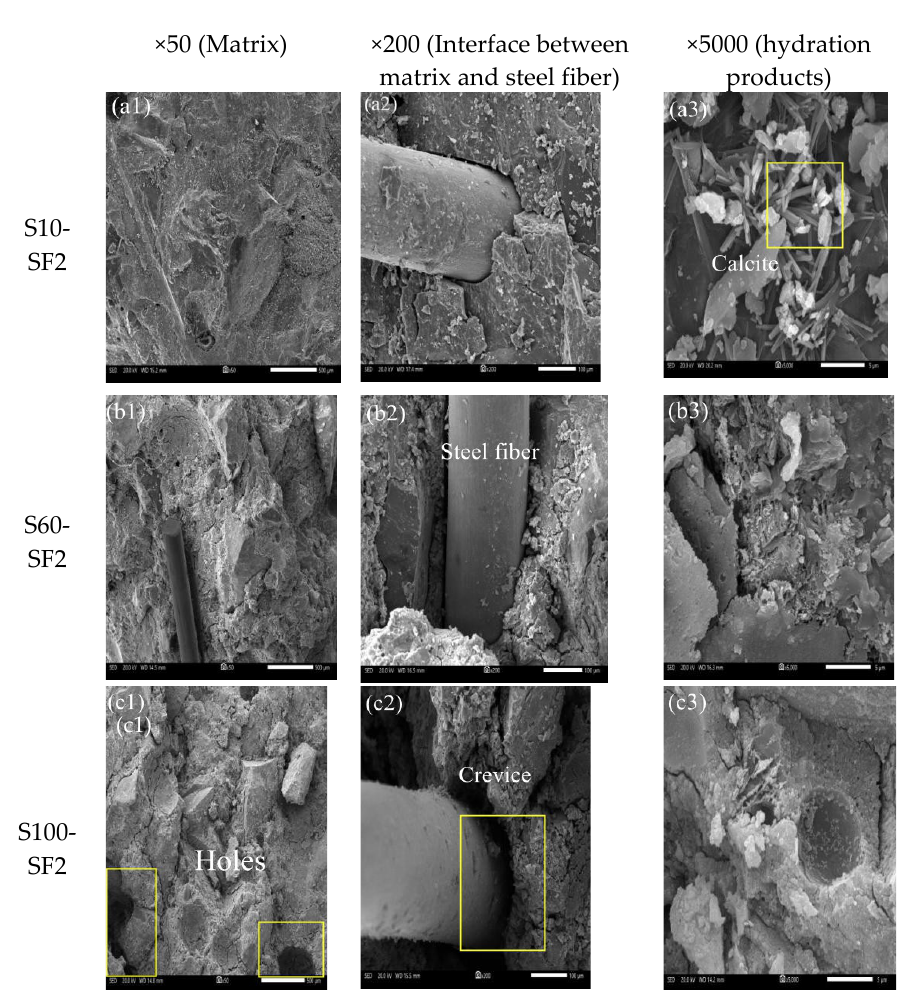
Figure 15. SEM images of AASSC with different substitution ratios of silicomanganese slag.